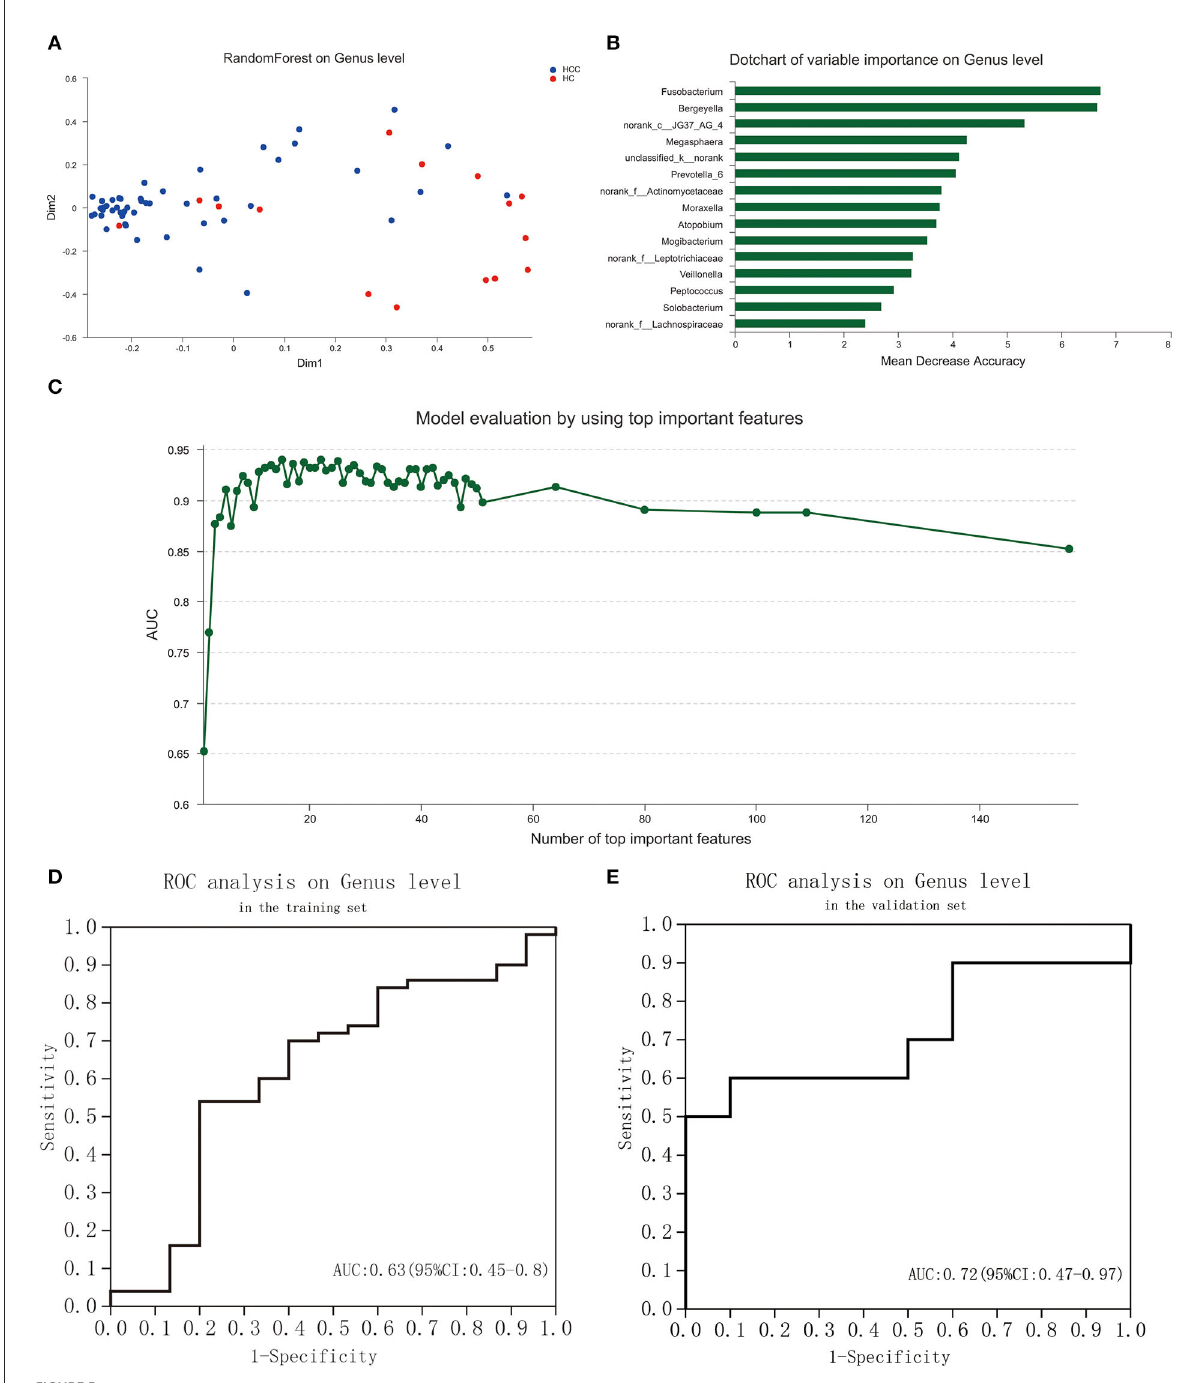
FIGURE5 Identification of a tongue-coating microbiome signature to discriminate HC and PLC by random forest analysis. (A) The two-dimensional scatter graph represents the similarity of samples in different groups. (B) Signature evaluation by using top 10 important features on genus level by random forest analysis. (C) Dot chart of top 15 variable importance on genus level. (D) ROC of the signature is based on the 15 most important variables in the training set. (E) ROC of the signature based on the 15 most important variables in the validation set. (PLC represents primary liver cancer, HC represents healthy